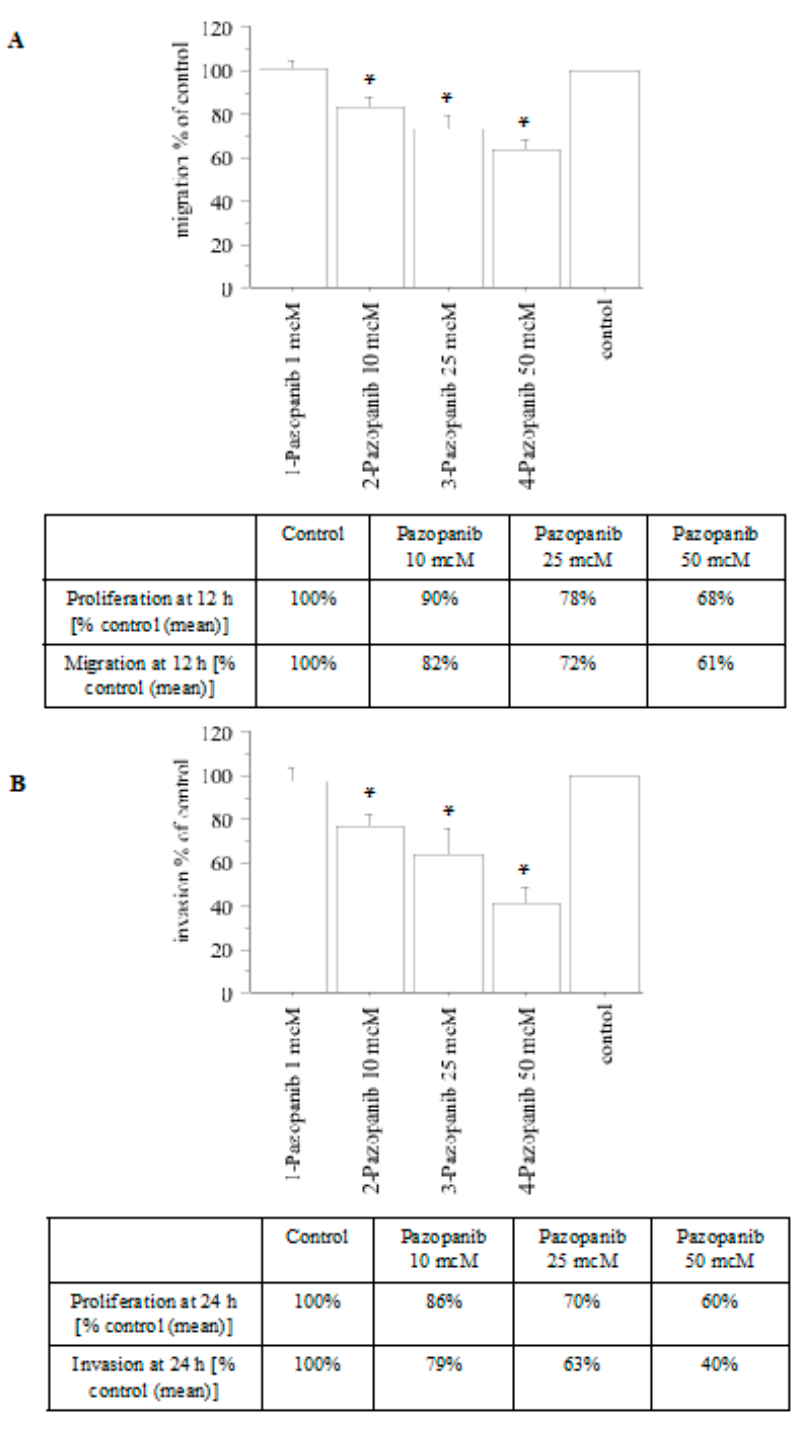
Figure 4. Migration and invasion assays in pATC cells treated with pazopanib. The migration test was performed for 12 h ( A ). For comparison, the inhibition of proliferation at 12 h (as a percentage vs. control) is reported in the table. The invasion test was performed for 24 h ( B ). For comparison, the inhibition of proliferation at 24 h (as a percentage vs. control) is reported in the table. Bars are the mean ± SD. * p < 0.05 vs. control (control = medium + FCS 10%) according to Newman–Keuls test.